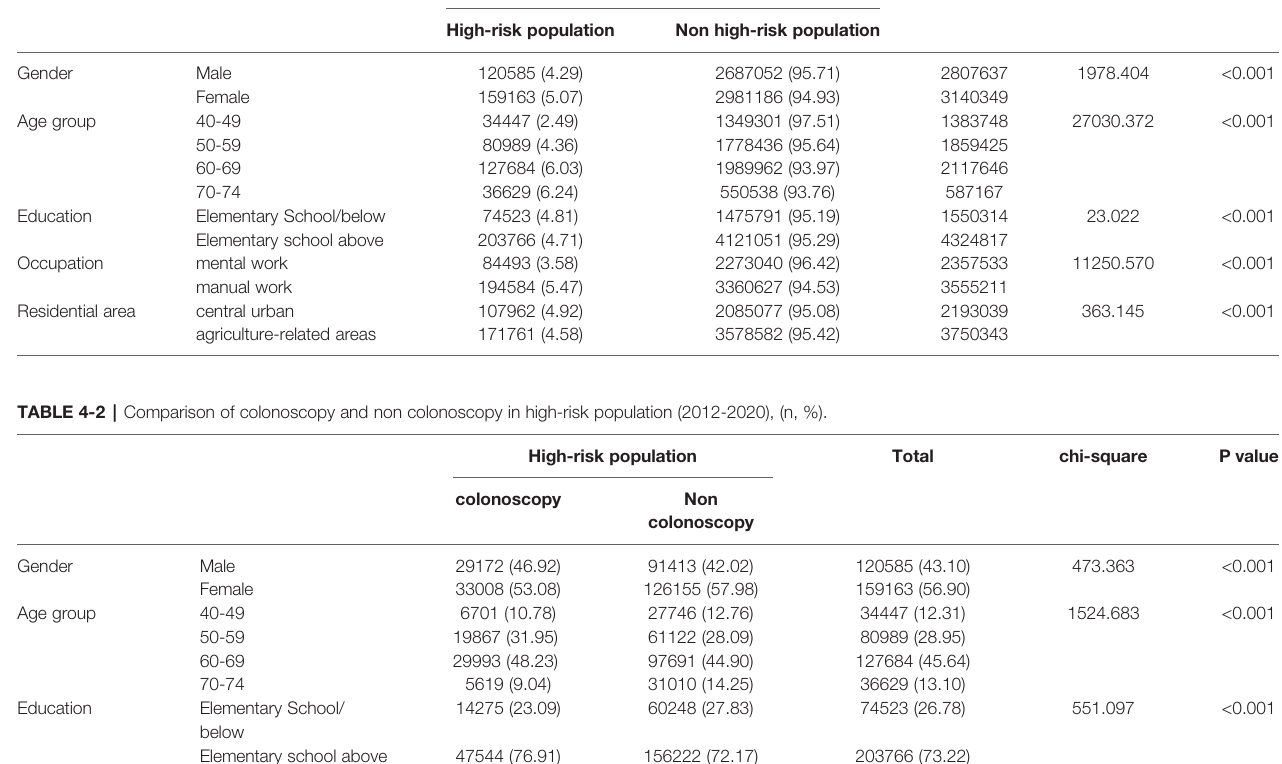
TABLE 4-1 | Comparison of high-risk population for different CRC screening populations (2012-2020), (n, %).